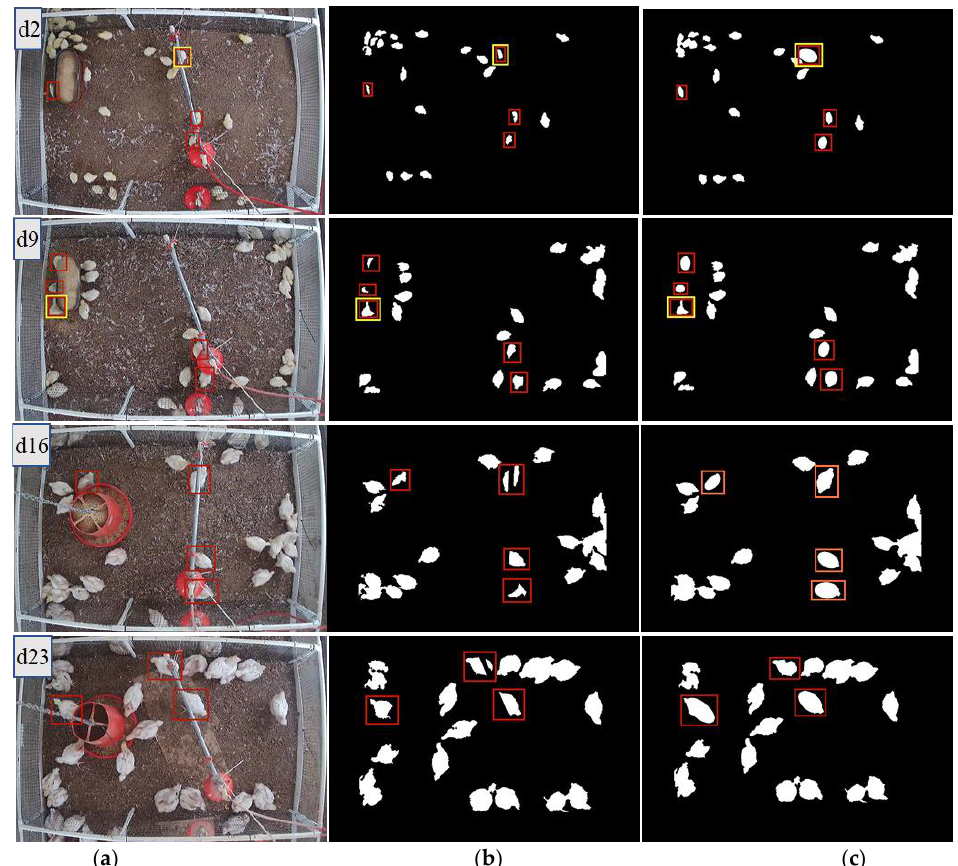
Figure 8. Restoration result of the occluded area. ( a ) original image; ( b ) the binary image of the broiler occluded area before restoration; ( c ) the binary image of the broiler occluded area after restoration. Red boxes are the broiler chickens occluded by the equipment. The yellow boxes are special cases, such as crowding.